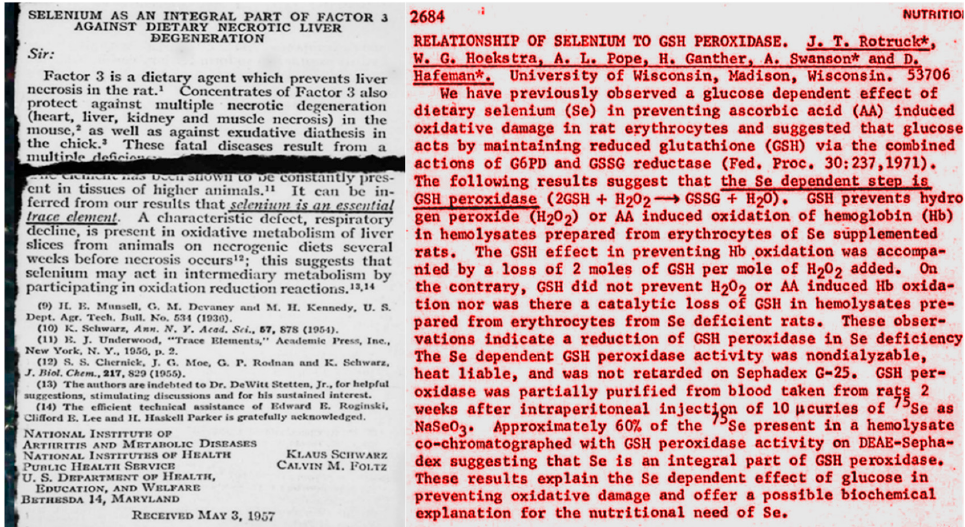
Figure 3. Milestones of biochemical selenium research. In the left panel the essentiality of selenium in mammals is documented for the first time [64]. Please, notice that the co-inventor, Dewitt Stetten, who smelled the selenium in the “factor 3” of Klaus Schwarz, is hidden in footnote 13. The right panel, colored in selenium red, claims, for the first time, that the GPx reaction depends on selenium [65]. It is the communication that prompted us to try an exact selenium determination in the last 0.69 mg of bovine GPx1 [66] left over from material-consuming kinetic studies with stopped-flow equipment [67].